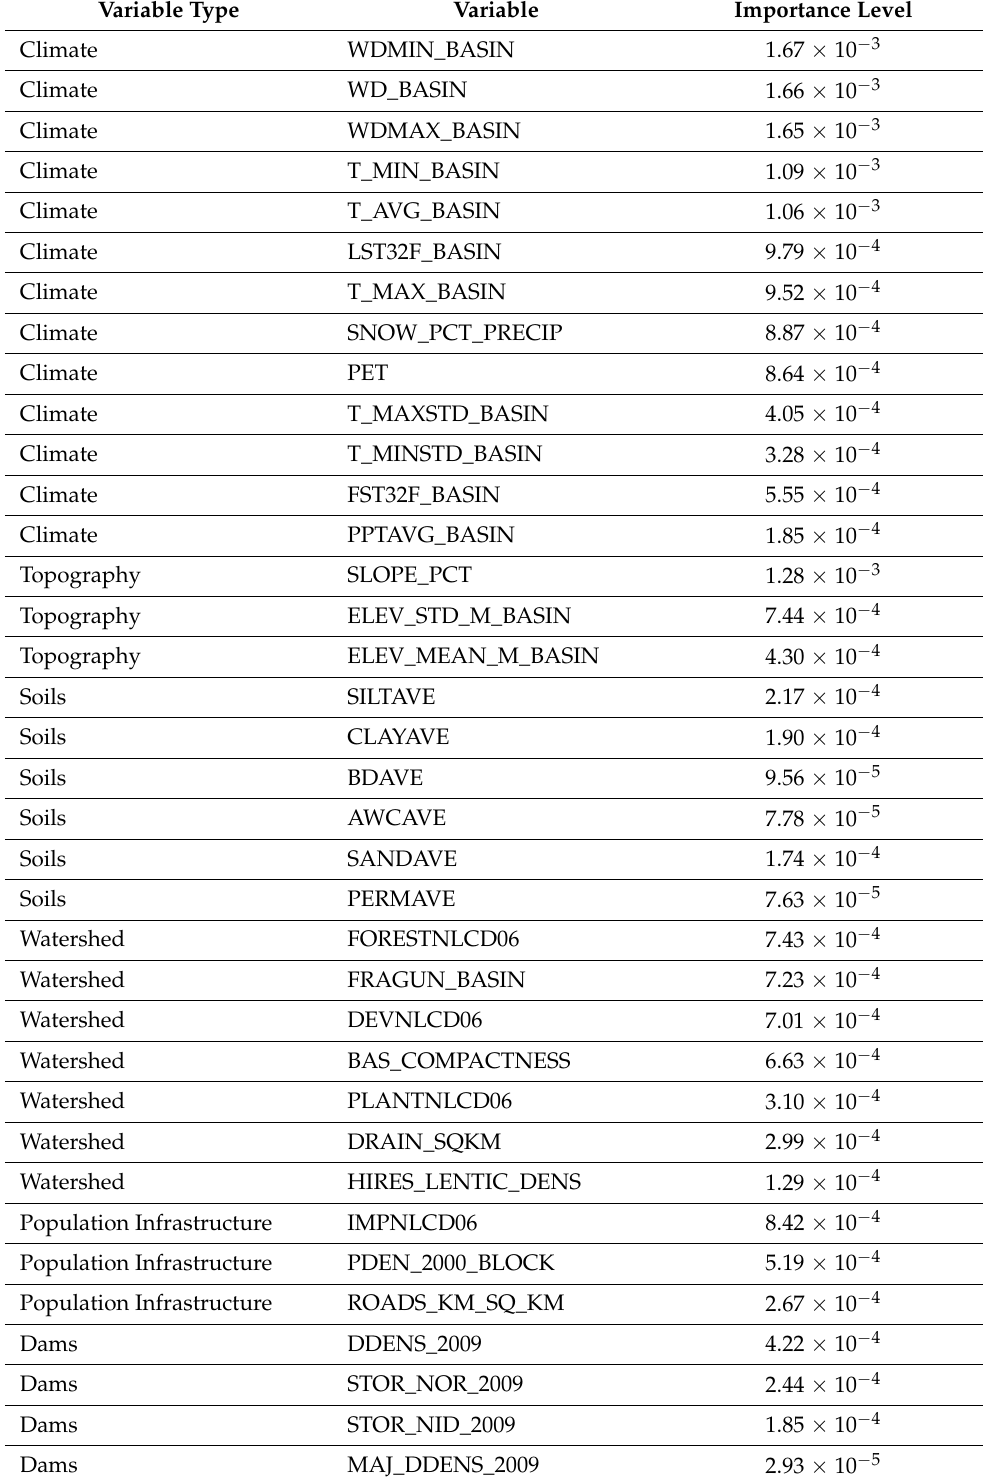
Table A5. Predictor variables retrieved for Appalachian